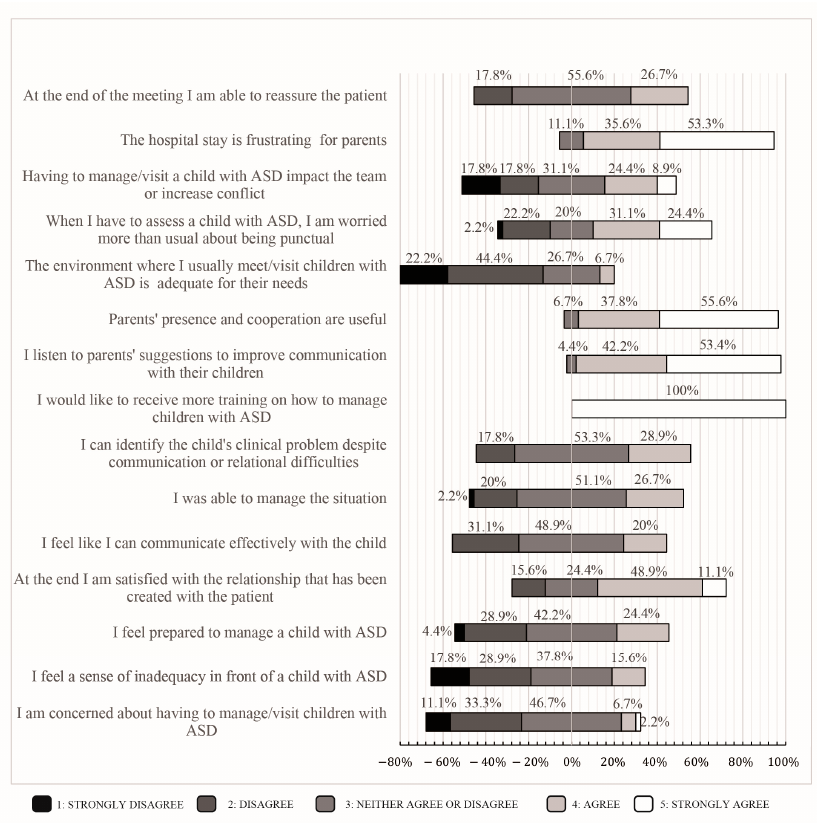
Figure 1. HP view of their interaction with ASD children and their families ( n = 45). The questionnaire items on a 5-point Likert scale, with answers provided as